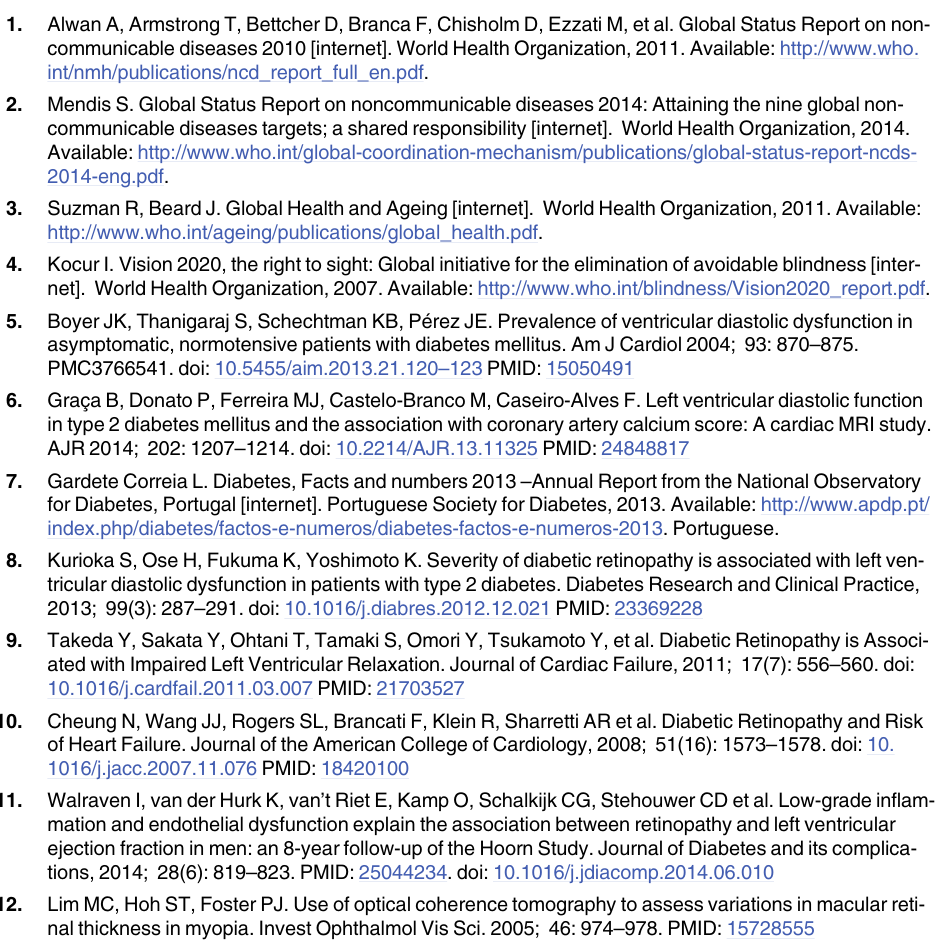
S2 Table. Descriptive statistics for Psychophysics (Speed, Achromatic and Chromatic Con- trast Sensitivity) data and comparison between types of participants. S3 Table. Descriptive statistics for True Fast Imaging Steady State Procedures (True-FISP) and comparison between types of participants. S4 Table. DA and LR Model